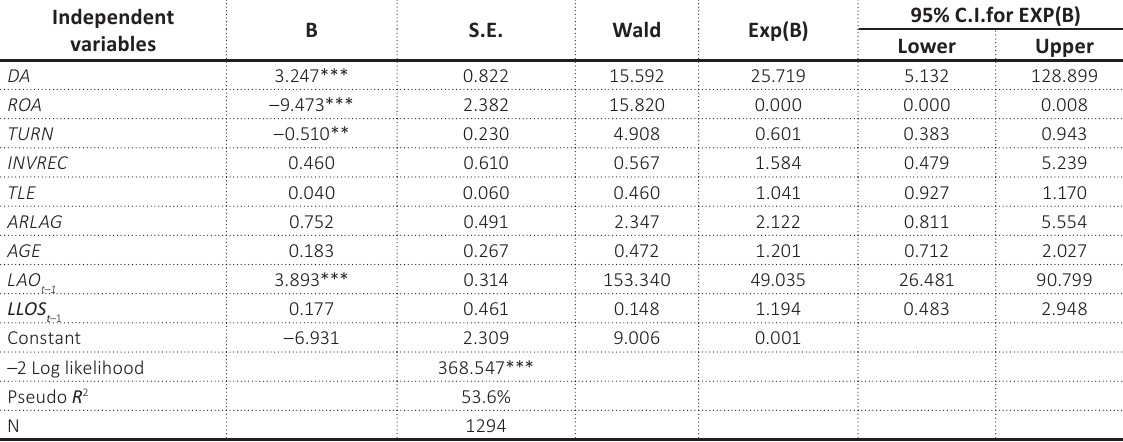
Table 4. Logistic regression results without BIGN variable Independent